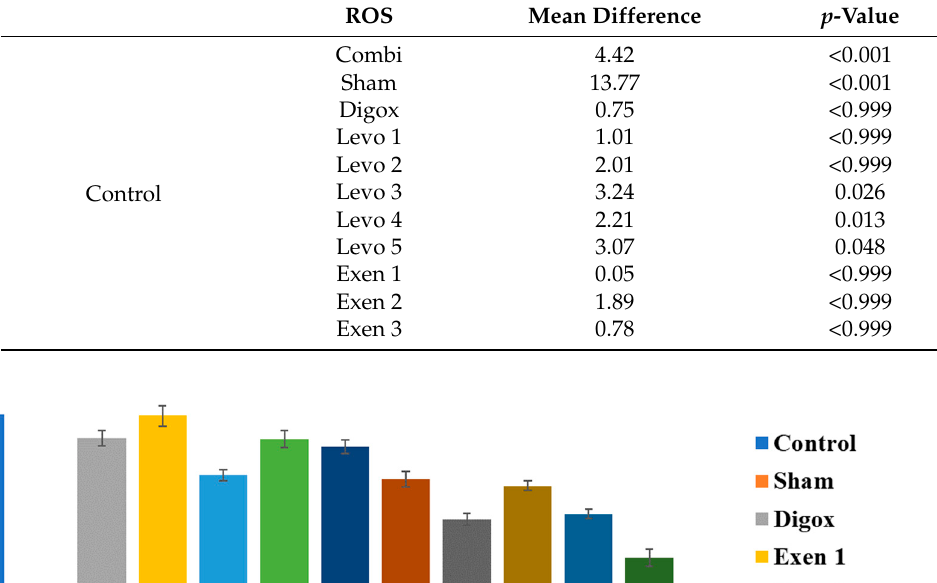
Table 19. Pairwise comparisons for Reactive Oxygen Species among groups.